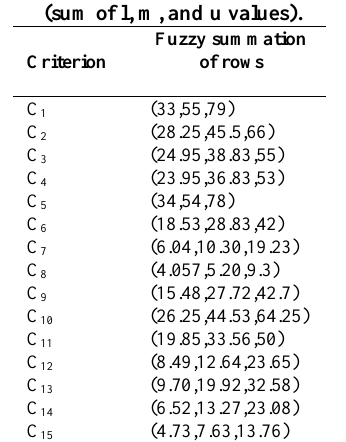
Table 10. Fuzzy summation of